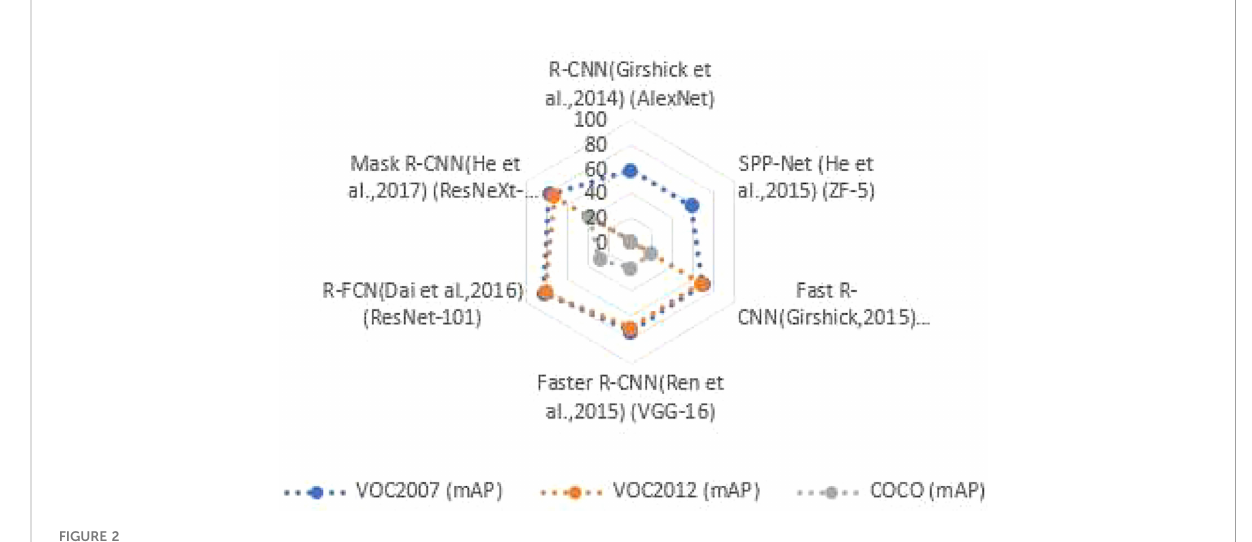
FIGURE 2 Performance comparison of two-stage object detection